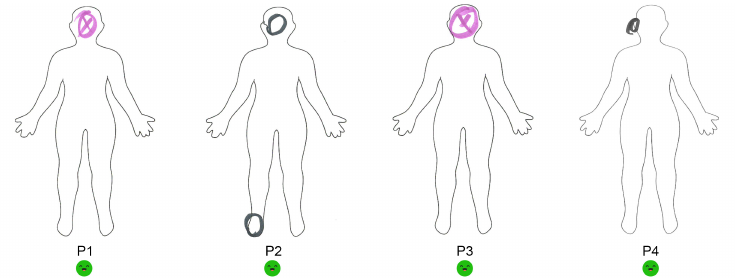
Figure 10. Body maps displaying where the students described that they could perceive vibrations when they were sitting in a wheelchair (WH). Green versus orange emojis represent the replies to whether the student liked or disliked the vibrations.